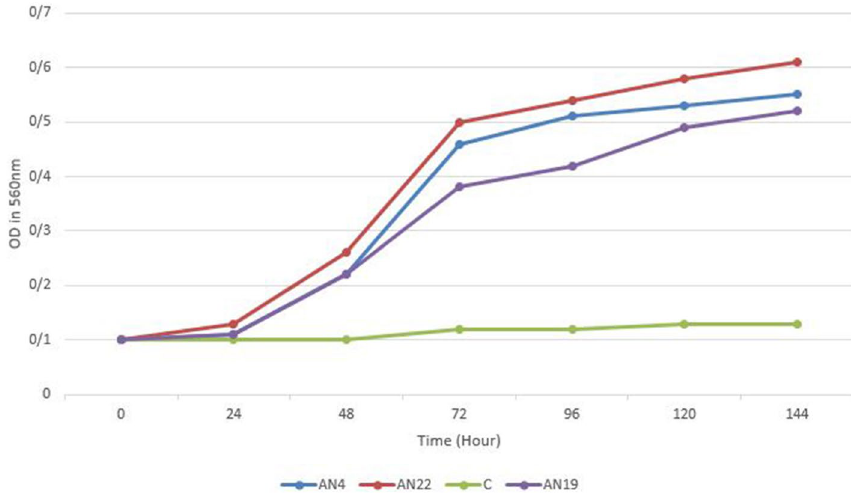
Figure 3. Growth curves of Iranian Nocardia isolates over a 24 h. Incubation period at 30 °C in the presence of PAHs. C control